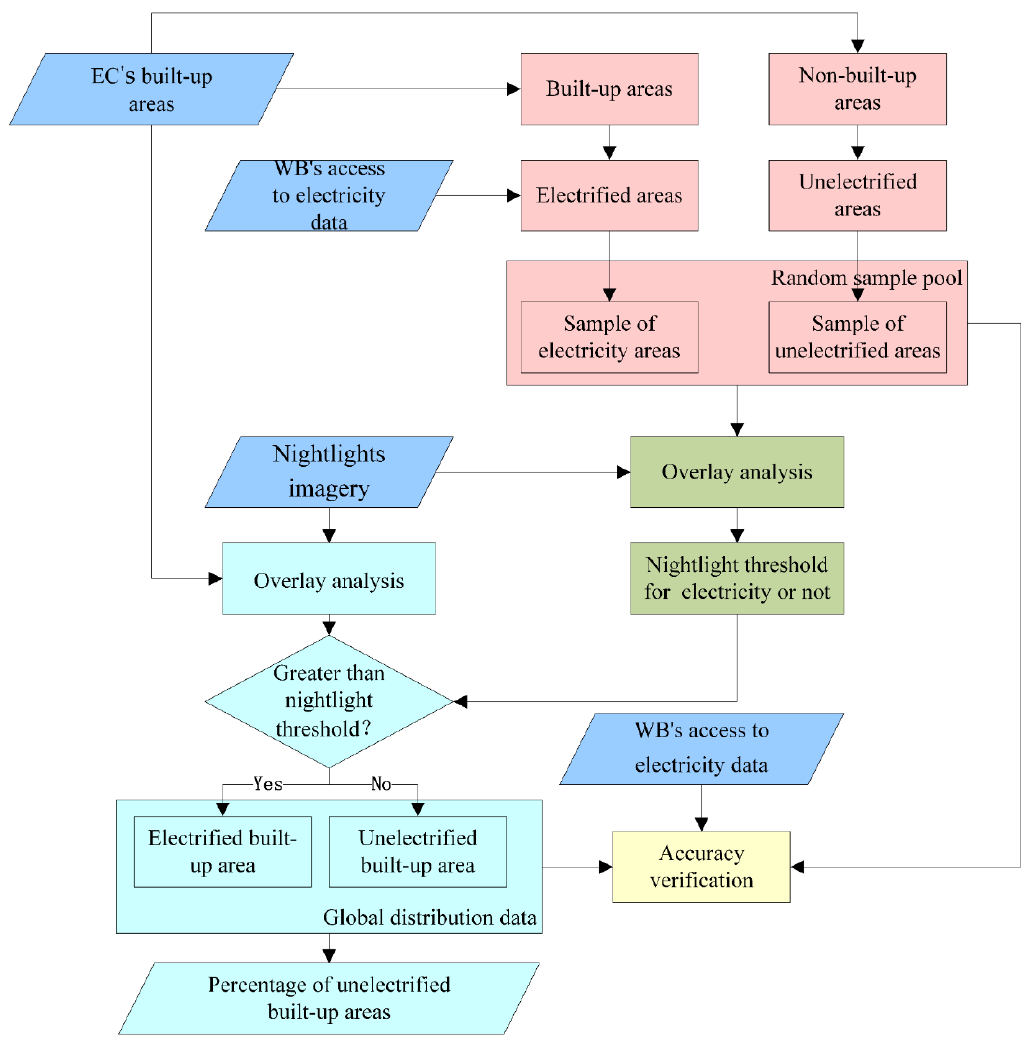
Figure 1. Technical flowchart of the method of non-electrified area identification.